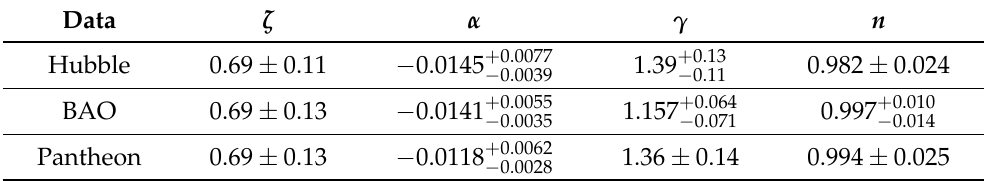
Table 2. The table shows the constraints on the model parameters corresponding to the Hubble, BAO, and Pantheon